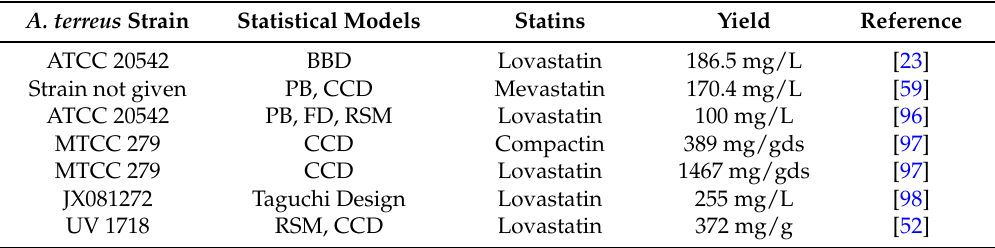
Table 5. Statistical approaches for media optimisation for production of statins by A.